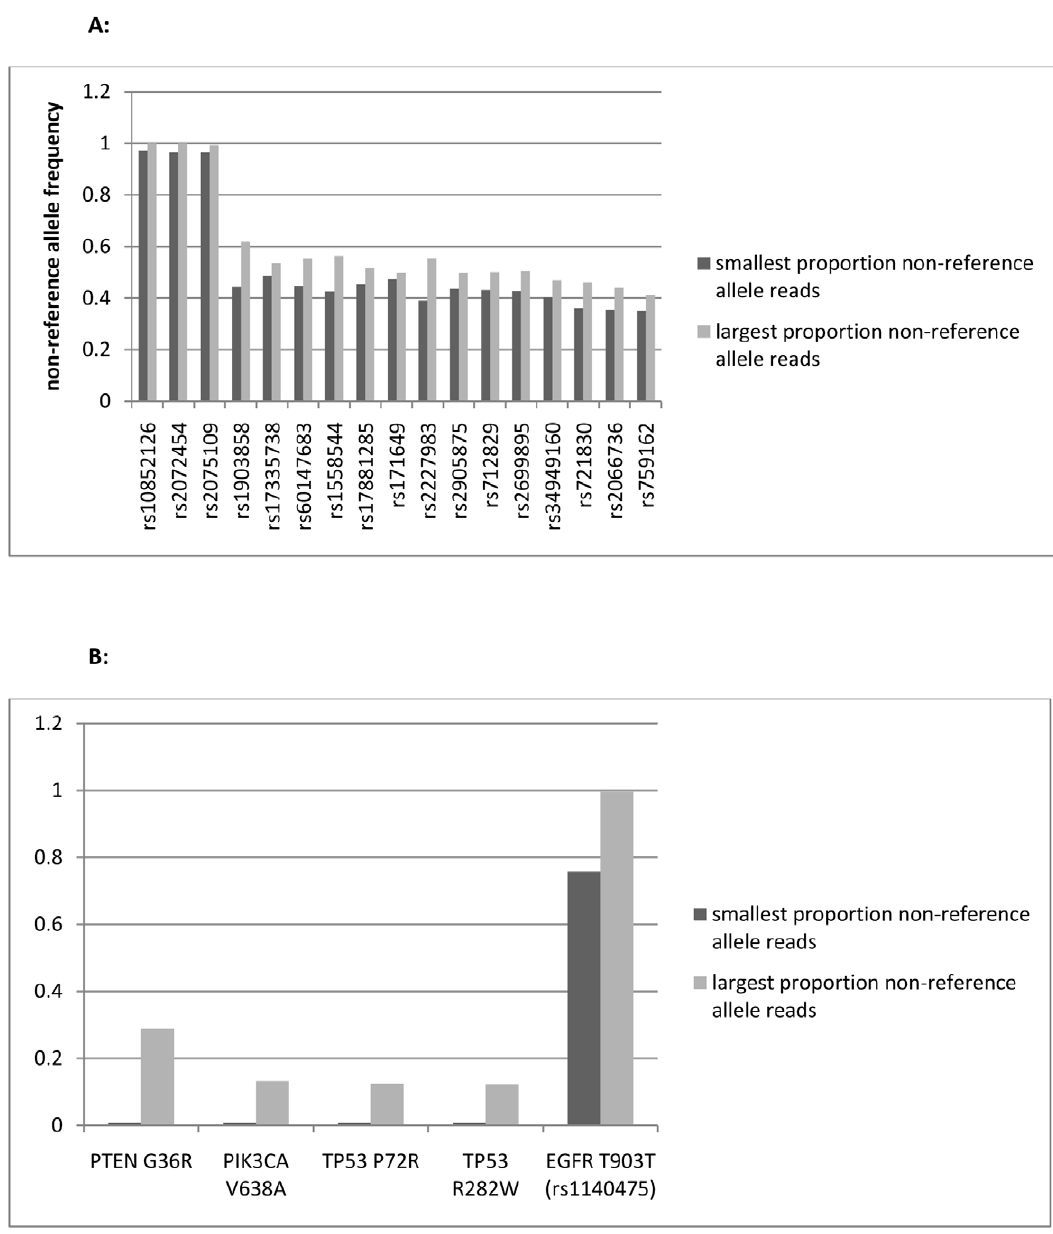
Figure 2. Distinguishing germline variants from somatic variants. (A) For each SNP, the non-reference allele frequencies for samples (out of seven) with smallest (black) and largest (gray) such frequencies are shown. In all samples, these frequencies do not deviate substantially from the germline frequencies. All SNPs in all samples have minor allele frequencies near the expected 50% or 100% and are therefore clearly and consistently distinguishable as either homozygotes (leftmost three) or heterozygotes (the remainder). (B) In contrast, the somatic variants display much wider ranges in allele frequencies across samples. Note that the absence of black bars is indicative complete absence of the mutation in some samples. doi:10.1371/journal.pone.0035262.g002 nucleotide variant (SNV) if, in a sample: (i) it was observed in at least seven independent reads, at least one of which came from each of the positive and negative strands; (ii) at least 10% of the reads carried the same non-reference allele; (iii) the base did not lie within a homopolymer repeat; and (iv) the base did not correspond to an alternate allele in a pseudogene region. The SNV sites were then queried in all other samples. Mutations with allele frequencies below 5% were disregarded as potential sequencing errors.